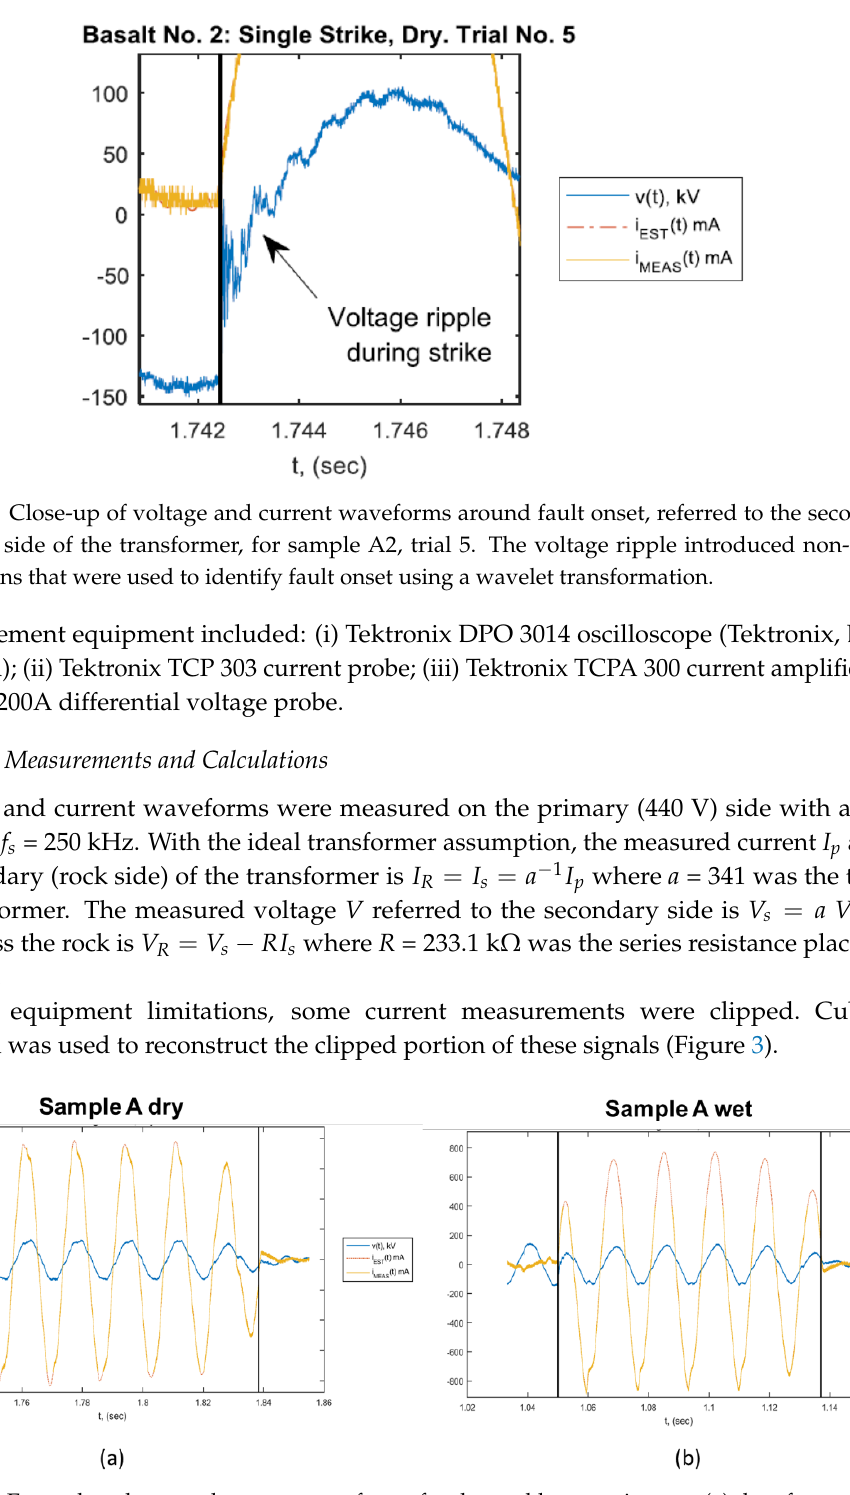
Figure 3. Example voltage and current waveforms for dry and let experiments: ( a ) data from sample A1 (dry), and ( b ) data from sample A3 (wet). The peaks of the current waveforms were reconstructed using cubic spline interpolation.